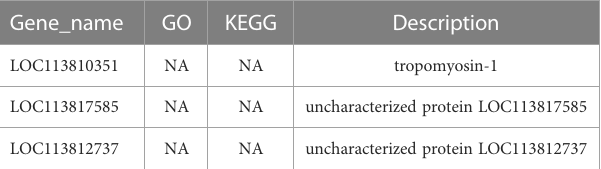
TABLE 3 The infection of Zoea larvae and adults with Vibrio parahaemolyticus co-down-regulates 3